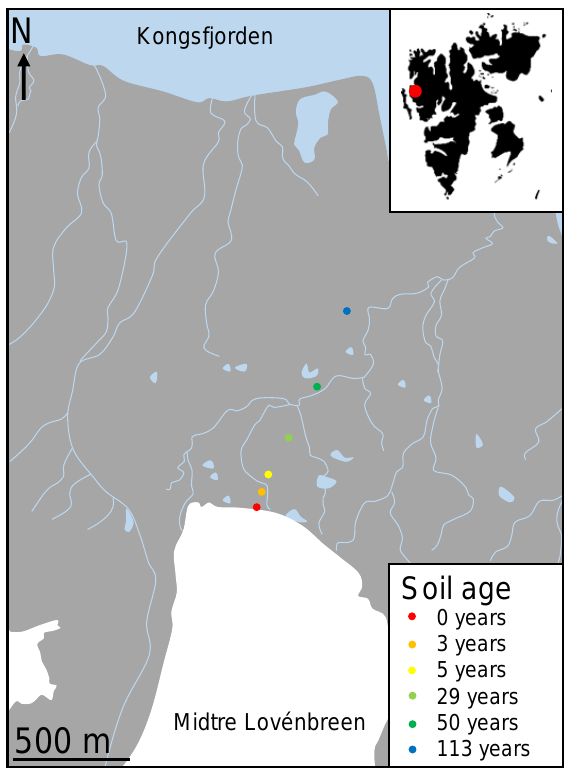
Figure 1. Midtre Lovénbreen glacier and forefield in Svalbard, the location of sampling sites, and approximate age of